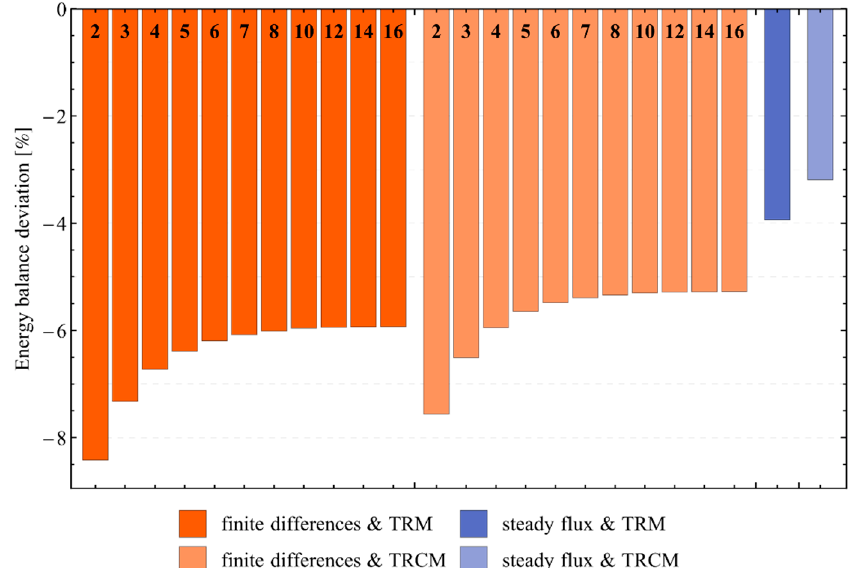
Figure 10. Relative deviation of the MoBTES models’ energy balance in relation to the monitoring data after 500 simulated days (number of local model capacities on finite differences bars).